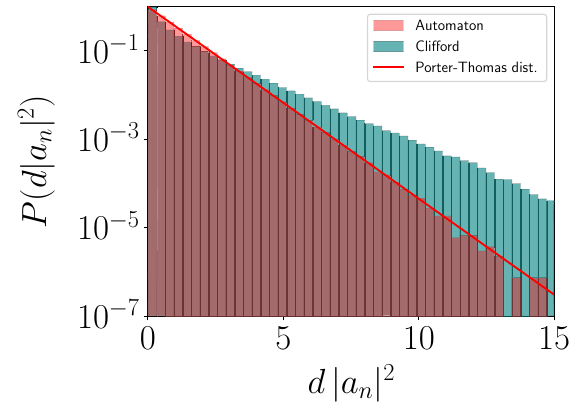
FIG. 2. The probability distribution of bit strings P ( 2 N | a n | 2 ) as measured in the x basis for automaton and Clifford wave func- tions on N = 16 sites. The fluctuations of bit-string amplitudes in the automaton wave functions obey the strict bound for unitary γ designs given by Eq. (18) up to at least γ ∼ N . The Clifford wave function, on the other hand, only obeys this bound up to γ ∼